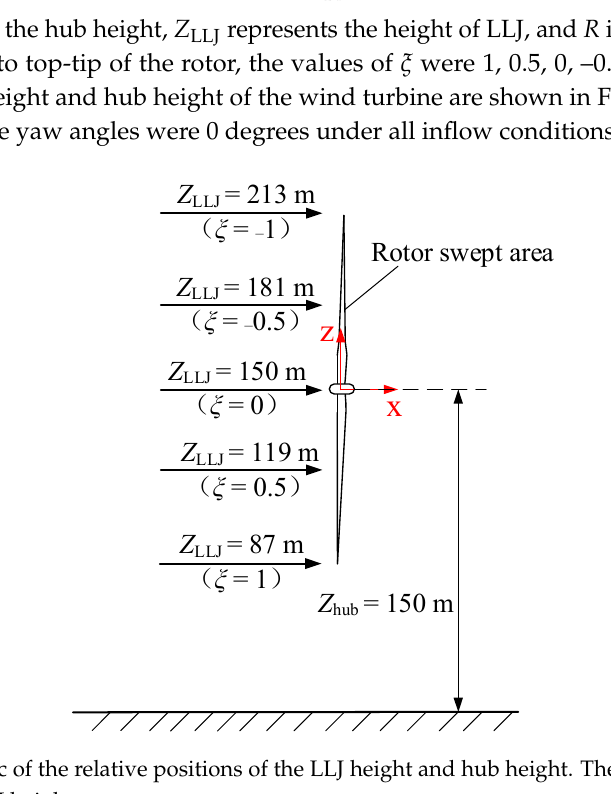
9 Figure 5. Rotor power at different wind speeds. FAST: fatigue, aerodynamics, structures, and turbulence.